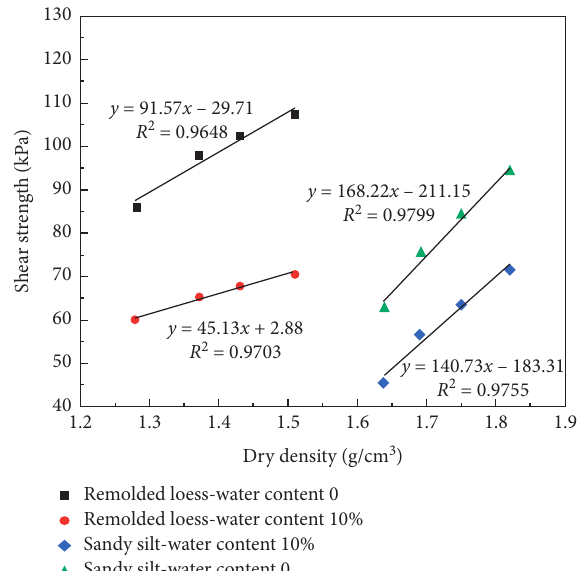
Figure 8: Relationship between dry density and shear strength of remolded loess and sandy silt.